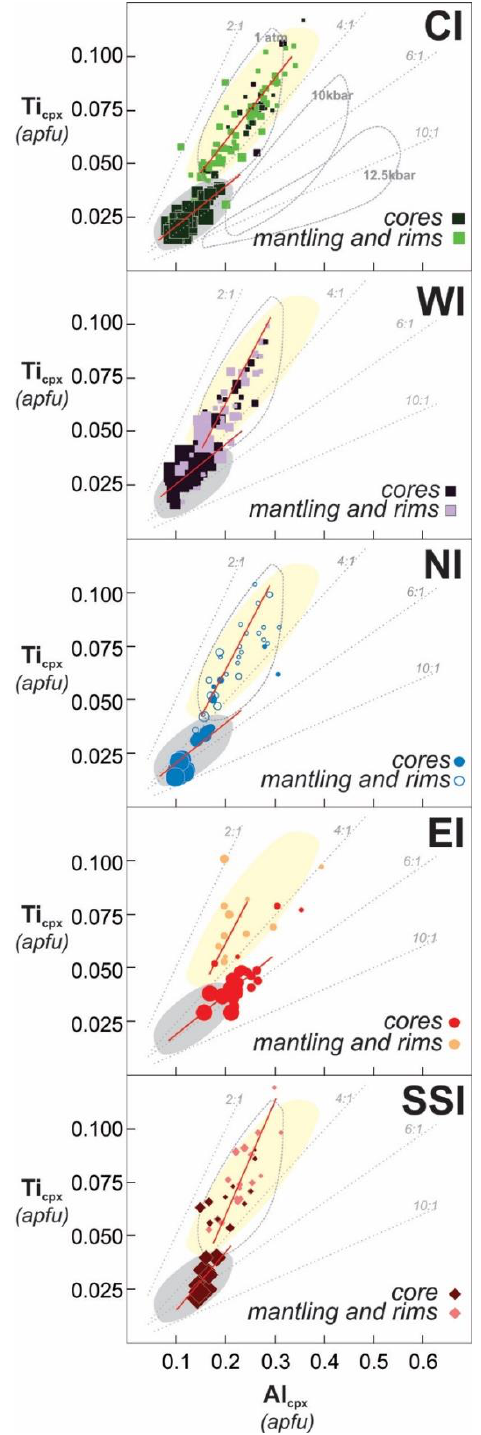
Figure 10. Ti versus Al (calculated to 6 oxygens) for the clinopyroxenes from the main intrusions of the PN massif, compared with the experimental data from [75] that correlates the proportion Al/Ti cpx with pressure. The size of the symbols is related to the Mg# cpx content (higher Mg#, bigger symbols). In this sense, high-Mg relict cores tend to present higher Al/Ti values than mantling and rims. Ti-augite mantling and rims in all intrusions are more compatible with low-pressure crystallization conditions, with diopside relict cores suggesting a deeper crystallization.